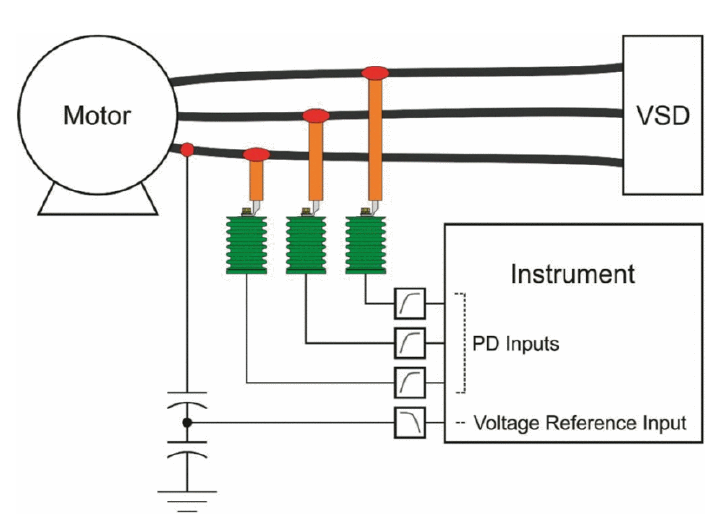
Figure 23. Structure of the PD measurement system